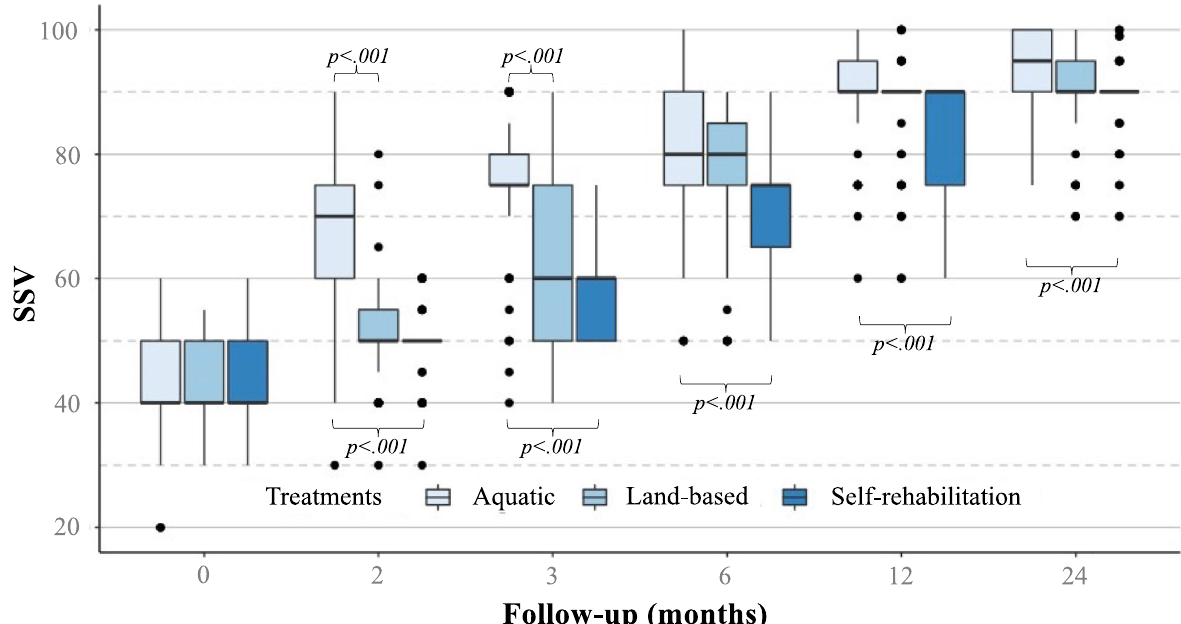
Fig. 3 SSV for aquatic therapy, land-based therapy, and self-rehabilitation therapy for 24 months following rotator cuff